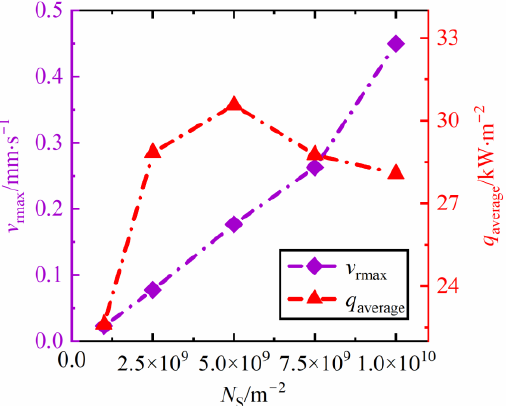
Figure 13. Maximum radius growth rate and average heat flux under different nucleus densities.